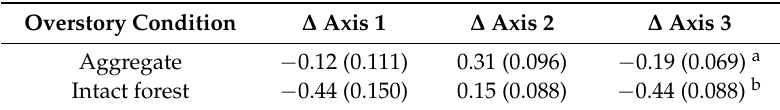
Table A4. Means with standard error in parentheses for differences in NMS Axis scores between observed (all distances from harvest edge) and reference plots (45 m into harvest) as they differed between intact forest versus aggregates. Lower-case letters in superscript indicate where the main factor, overstory type, was significant.